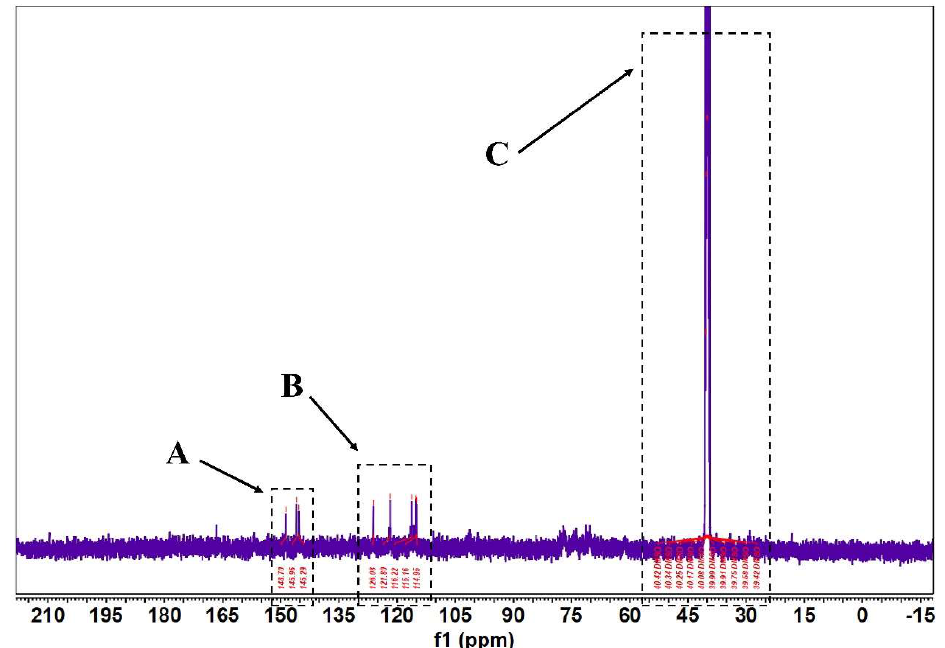
Figure 6. FML NMR carbon spectra (13C NMR). (Note: The δ values of c2~c3 signals in both part A and part B of FML were concentrated between δ 114.95~126.09 and δ 145.29~148.70; Part C is the DMSO D6).